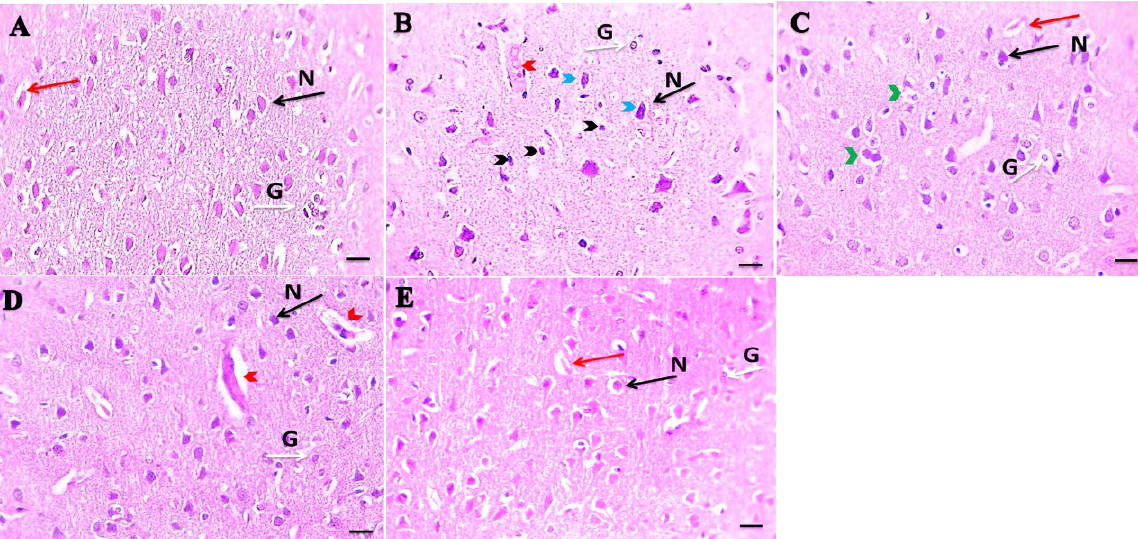
Figure 2. Histopathological examination of the prefrontal cortex of brain stained with H&E. ( A ) Prefrontal cortex specimen from control group showing normal pyramidal neurons (N) (black arrow), glial cells (G) (white arrow) and blood vessels (red arrow), ( B ) prefrontal cortex specimen from nicotine group showing marked damage characterized by shrinkage (blue arrowheads), apoptosis (black arrowheads) in pyramidal neurons with congested blood vessels (red arrowhead), ( C ) prefrontal cortex specimen from nicotine + cinnamon oil group showing mild damage characterized by pericellular edema (green arrowheads), ( D ) prefrontal cortex specimen from nicotine + ginger oil group showing mild damage characterized by congested blood vessels and perivascular edema (red arrowheads), and ( E ) prefrontal cortex specimen from the nicotine+cinnamon oil+ginger oil group showed an improved histological appearance of pyramidal neurons (N) (black arrow), glial cells ( G ) (white arrow), and blood vessels (red arrow). H&E X: 400 bar 50.